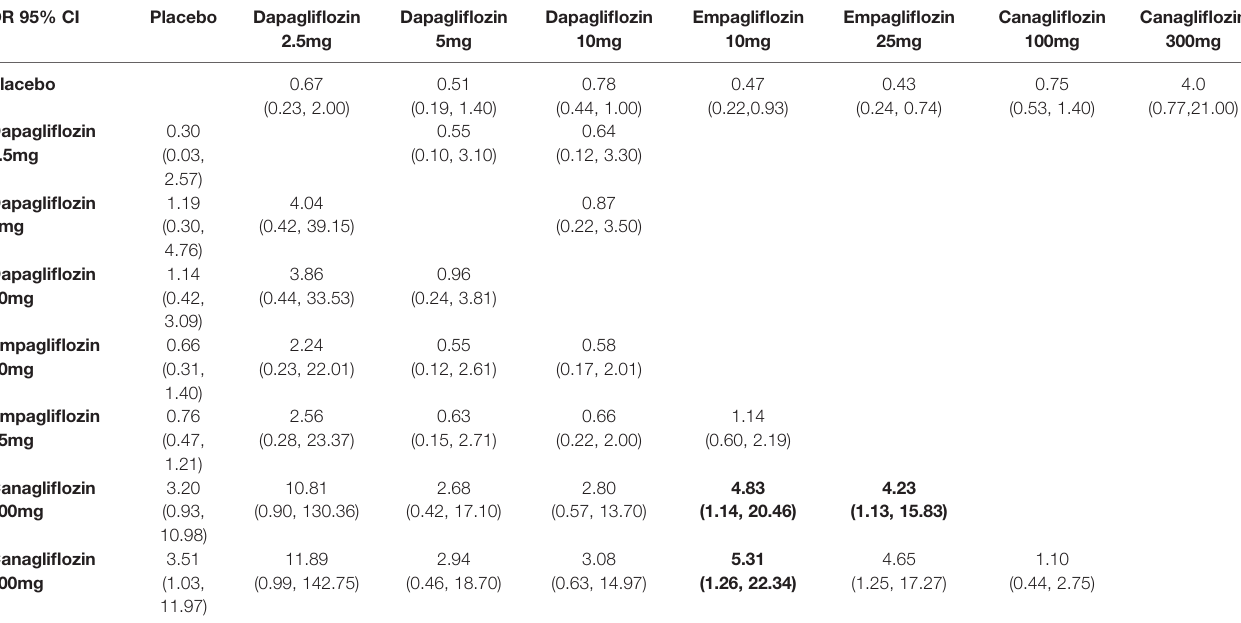
TABLE 3B | Summary of results from network meta-analysis and traditional pairwise meta-analysis on cardiovascular events. OR 95% CI Placebo